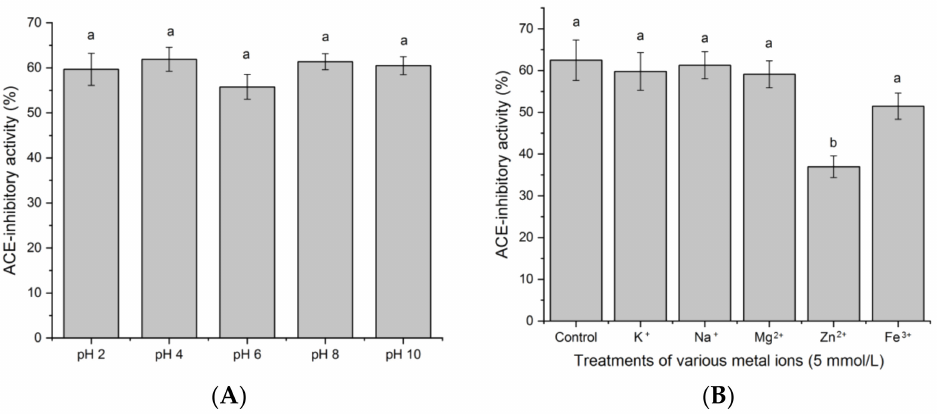
Figure 7. Stability of SAPPP ( A ) against different pH values; and ( B ) addition of different metal ions. Different lowercase letters (a–b) above the bars indicate significant differences ( p <